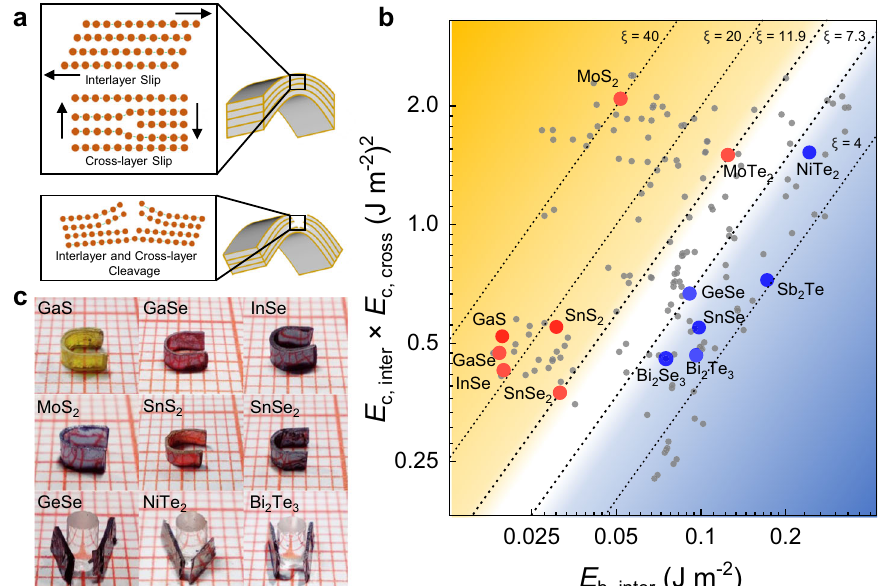
Fig. 2 | Plastically deformable 2D vdW chalcogenide crystals discovered by high-throughput screening. a Schematics of the plastic (up) and brittle (down) bending deformations. The interlayer/cross-layer slips and/or cleavages are high- lighted. b E c,inter × E c,cross vs. E b,inter for 2D vdW crystals. Each point represents a 2D